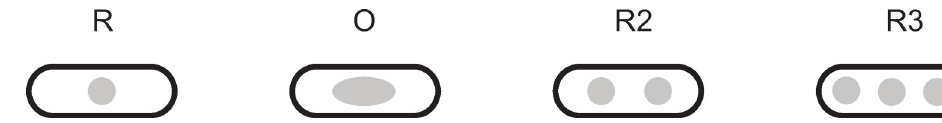
Fig 9. Canal morphologies in cross section. Gray is canal shape, black is external form of the tooth root.